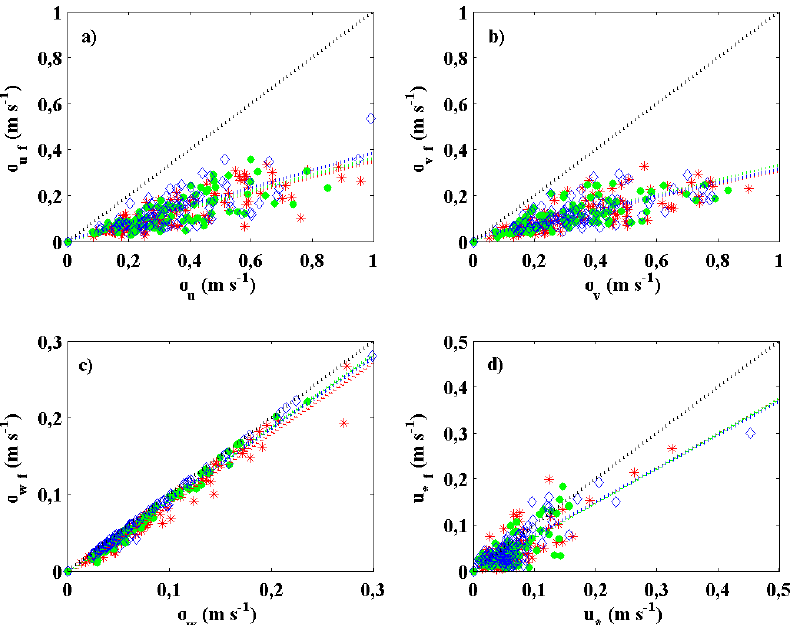
Figure 10. Scatter plot of unfiltered turbulent statistics versus the same statistics corrected for the wave effect: standard deviation of the longitudinal ( a ), lateral ( b ) and vertical wind velocity component ( c ), and friction velocity ( d ). The different colours and symbols refer to the different levels of measurement: red stars (10 m), green points (4.5 m), blue diamonds (2 m). Coloured dotted lines represent the linear best-fit regression lines whereas the black dotted line represents the 1:1